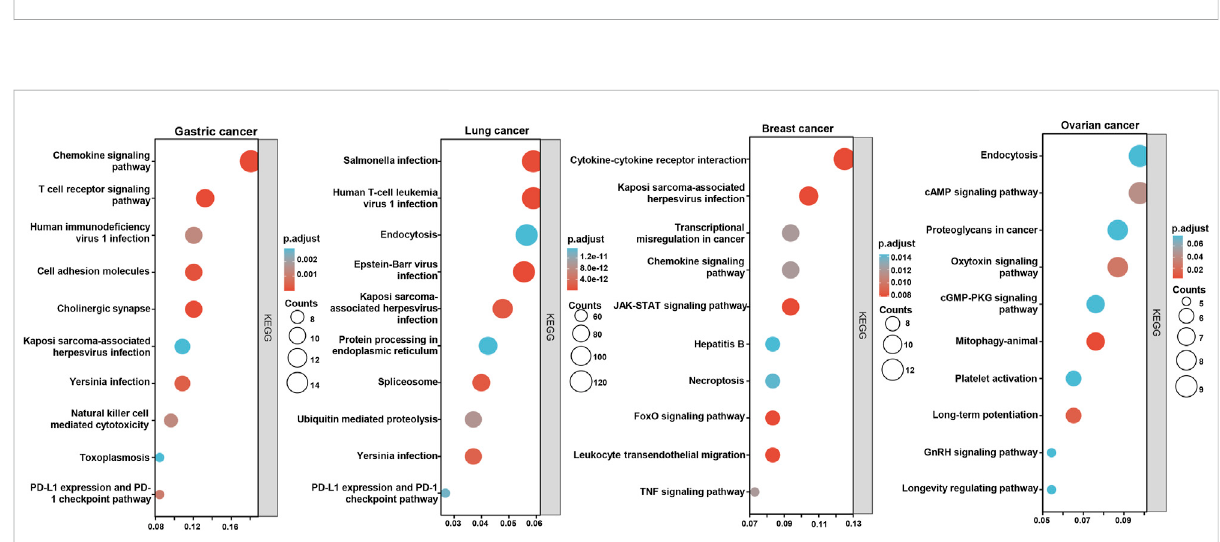
FIGURE 6 The differential genes and related signal pathways about BTG1 in cancers The differential genes of BTG1 were subjected to the signal pathway analysis using KEGG (A) . STRING was used to identify the protein-protein interaction network of differential genes about BTG1 in cancers, and cytoscape was employed to fi nd out the top 10 hub nodes ranked by degree (B) .